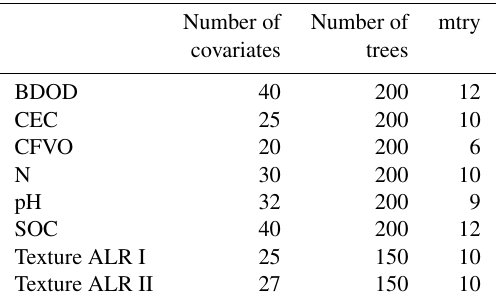
Table 3. Hyper-parameters for each considered soil property. See Table 1 for abbreviations and units of the soil properties